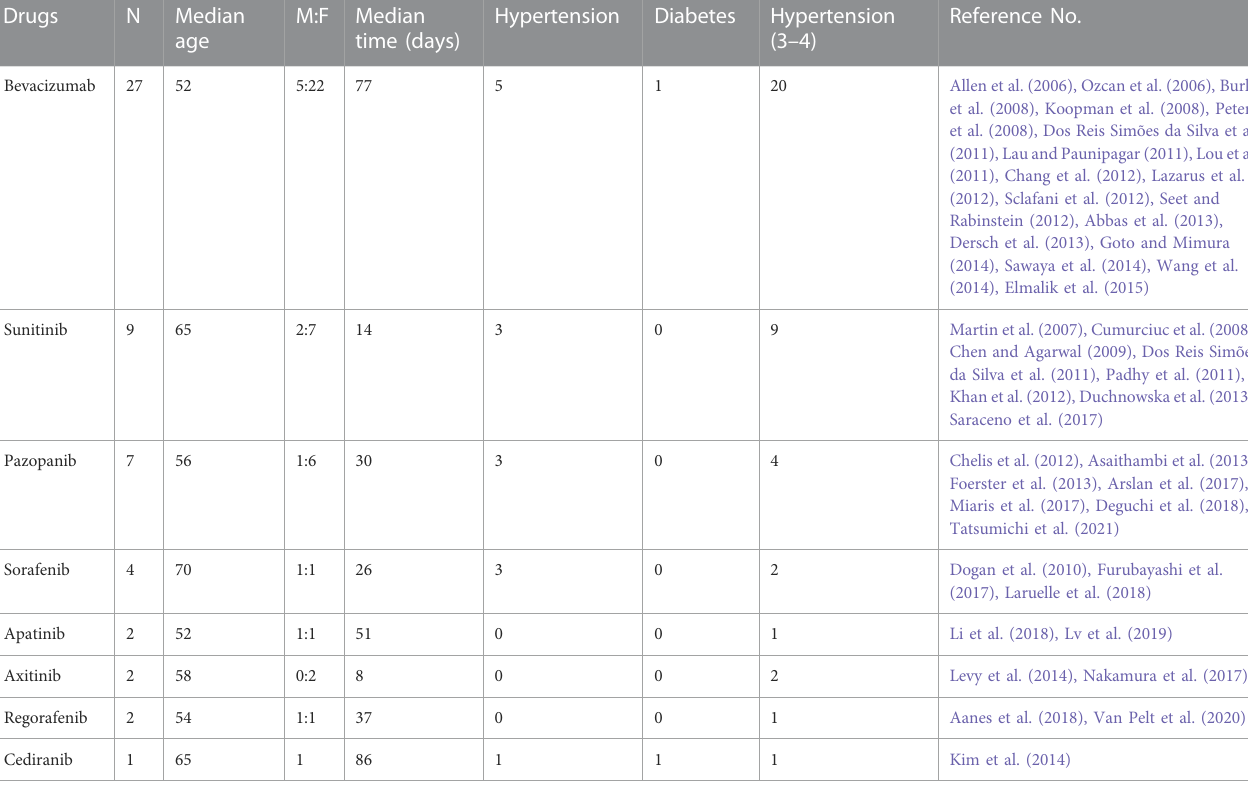
Table 2 summarized the common MRI fi ndings in 54 PRES patients.